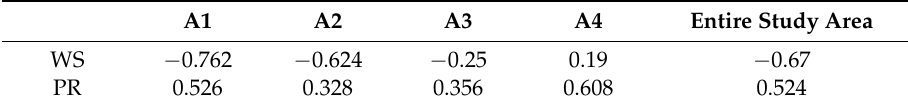
Table 1. Pearson correlation coefficients between the mean total suspended solids (TSS) concentration value of four sub-regions and all study areas. Red font represents the correlation between the average value of the region’s TSS concentration and the variables ( p <0.05).